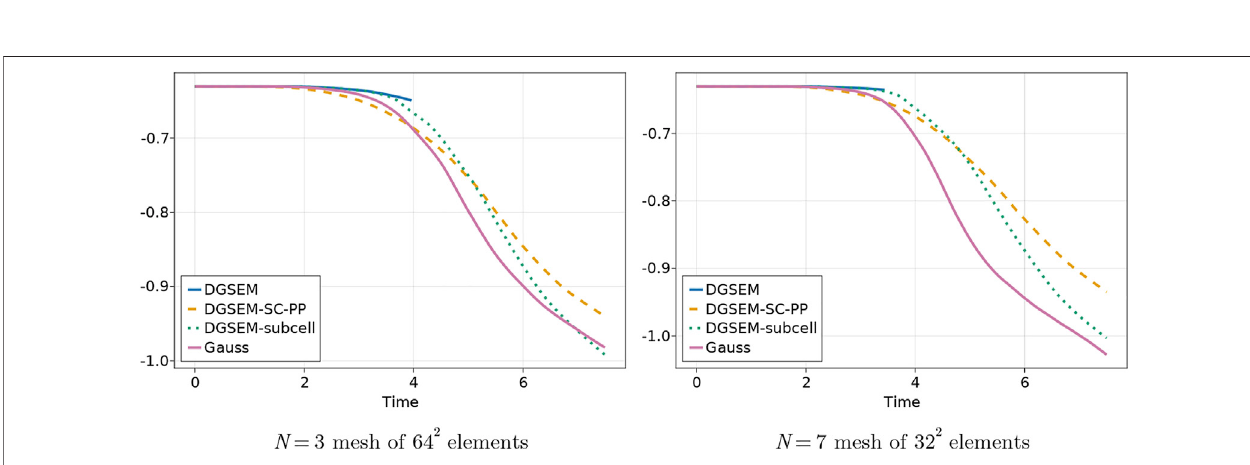
FIGURE8| Illustration oftheeffect oflarger k (under-resolution) andsmaller p min (near-vacuumstate) ontheentropyprojection. Adegree N =2approximationand mesh of 8 elements were used.